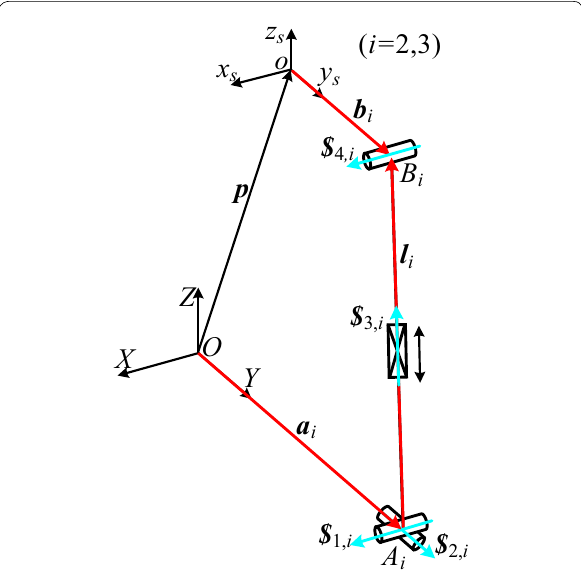
Figure 6 Actuating limb